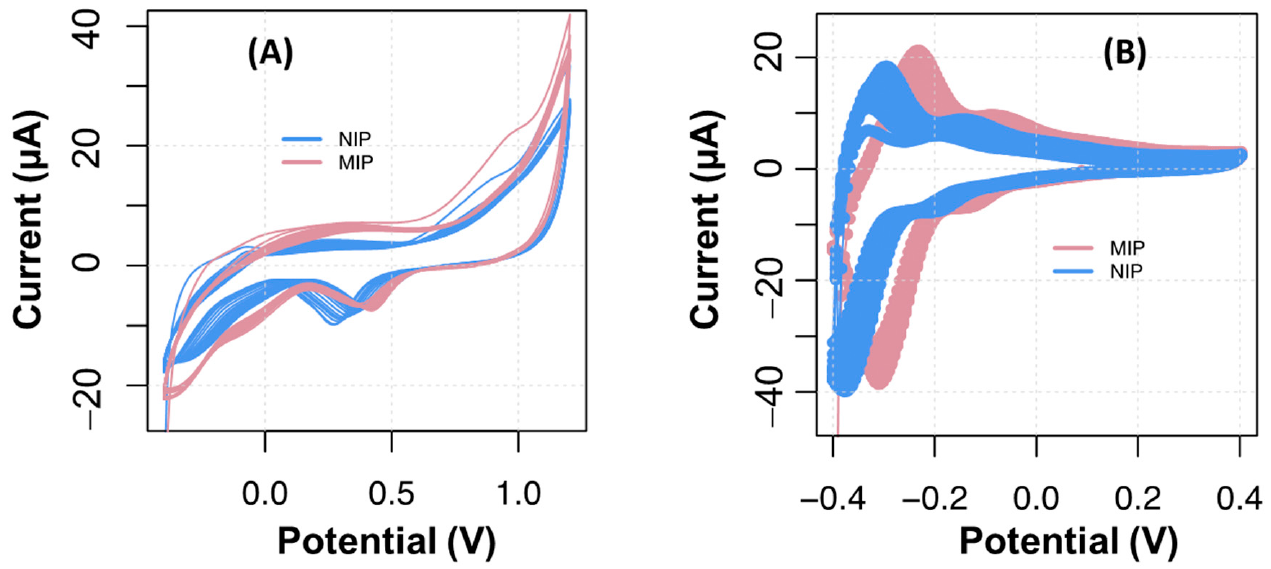
Figure 3. Consecutive voltammograms of a TH solution of 1.0 × 10 − 3 M prepared in phosphate buffer, pH 7.4, with CA 19-9 (MIP, pink), without CA 19-9 (NIP, blue), and first electropolymerization (gold line), on the ( A ) gold electrode and the ( B ) carbon electrode.